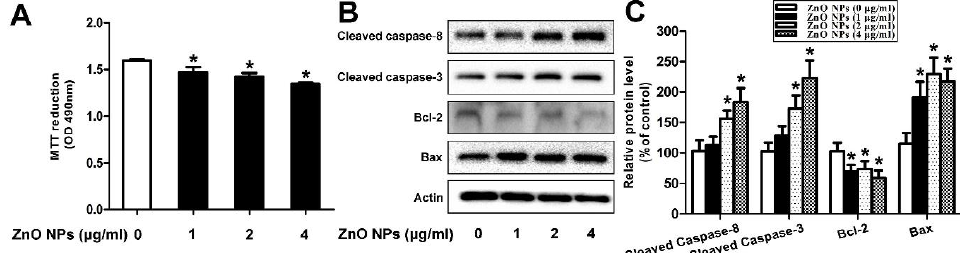
Figure 21. ZnO NPs induces apoptosis in murine GC-1 spg cells treated with 1–4 μg/mL ZnO NPs for 24 h. ( a ) Cell viability determined from 3-(4,5-dimethylthiazol-2-yl)-2,5-diphenyltetrazolium bromide (MTT) assay, ( b ) protein levels of Bax, Bcl2, cleaved caspase 3 and cleaved caspase 8, and ( c ) relative protein level vs control. * p < 0.05 compared to control. Reproduced from [49] under the Creative Commons Attribution license.